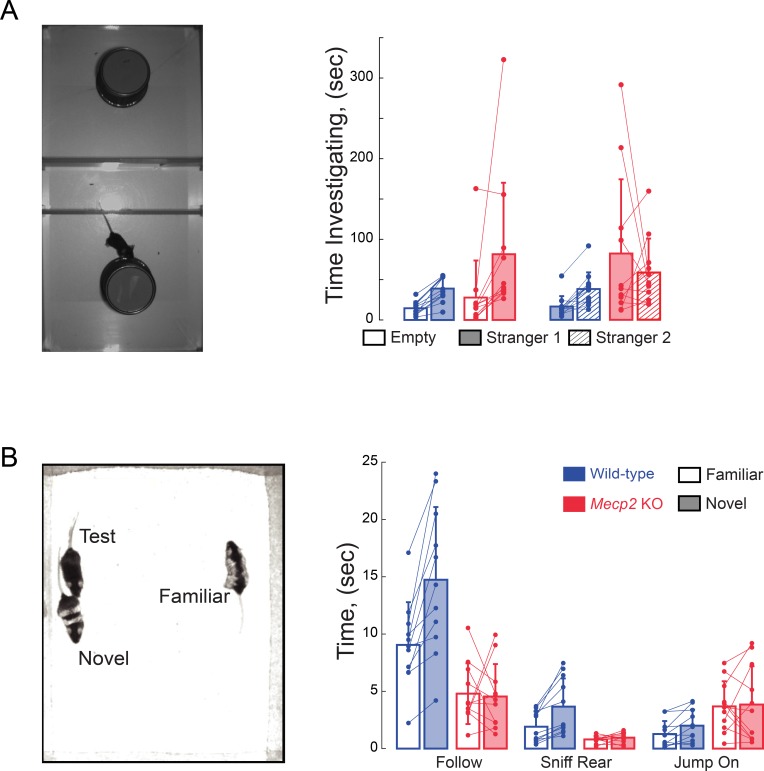
Impaired social memory in Mecp2 KO mice.(A) Total investigation times in the three-chamber sociability and social memory tests (n = 12 WT mice; n = 11 Mecp2 KO mice). (B) Total times during unrestricted social behaviors (n = 11 WT mice; n = 11 Mecp2 KO mice). Mean ± SD.10.7554/eLife.44182.008Figure 2—figure supplement 1—source data 1.Impaired social memory in Mecp2KO mice.